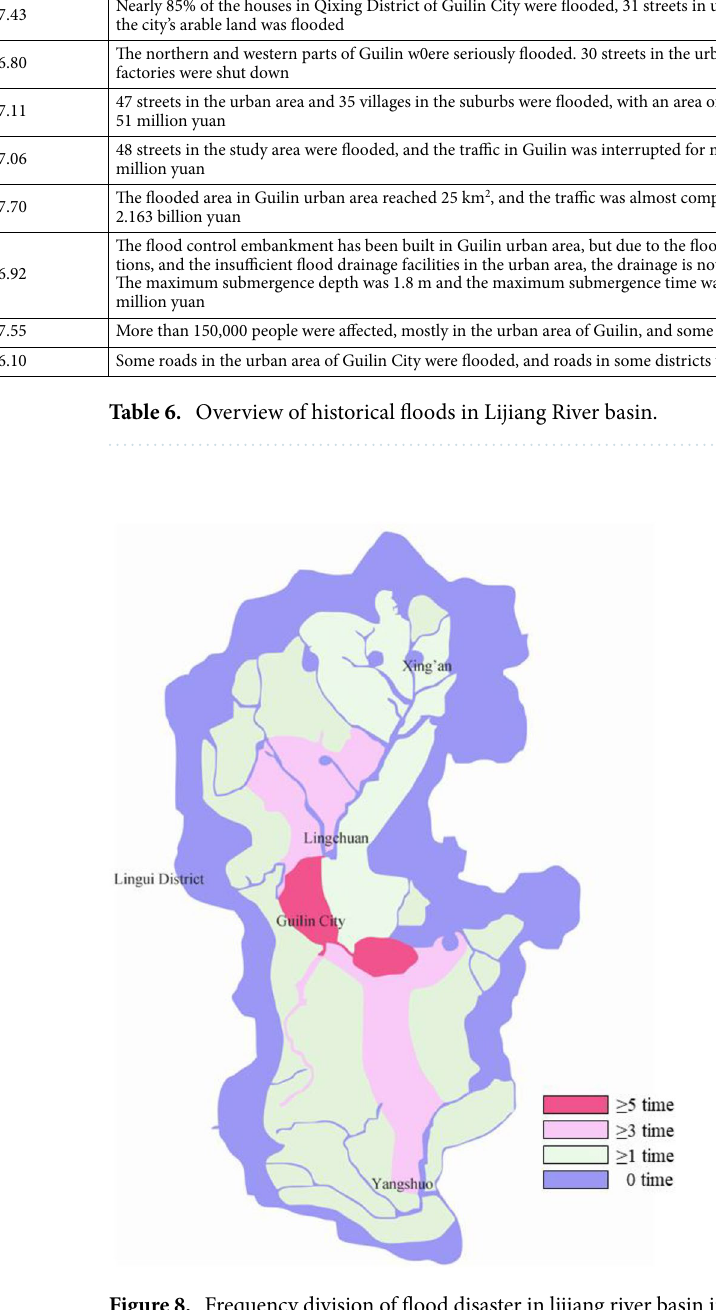
Figure 8. Frequency division of flood disaster in lijiang river basin in recent 60